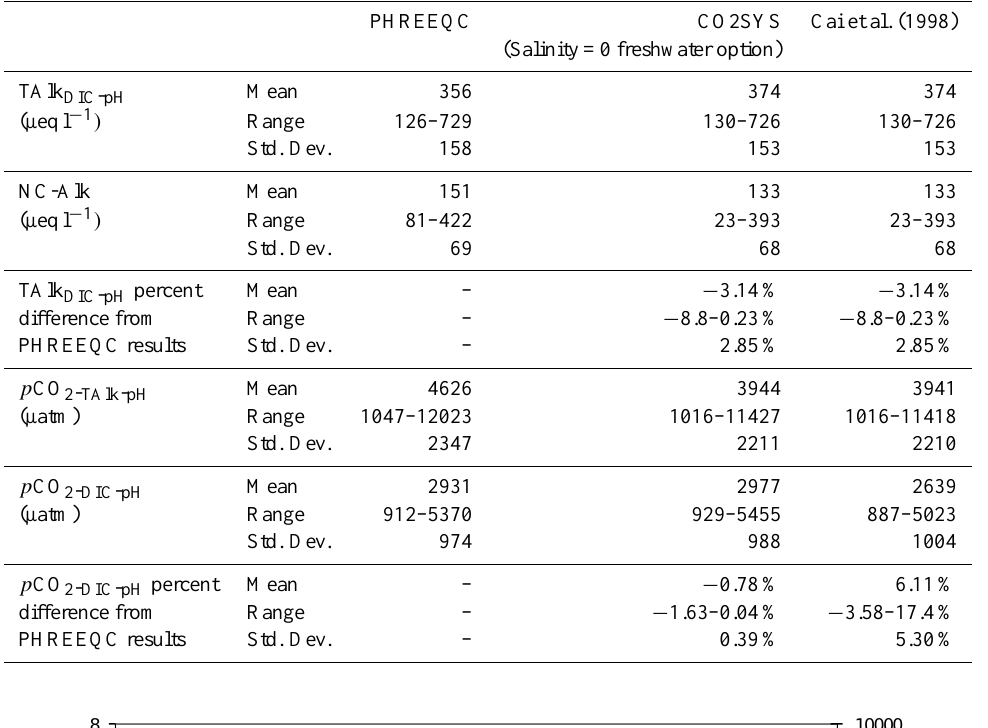
Table 1. Comparison of programs used in carbonate system calculations. TAlk DIC - pH is the total alkalinity derived from DIC and pH measurements. p CO 2 - TAlk - pH is the partial pressure of carbon dioxide derived from TAlk and pH measurements, while p CO 2 - DIC - pH is the partial pressure of carbon dioxide derived from DIC and pH measurements.